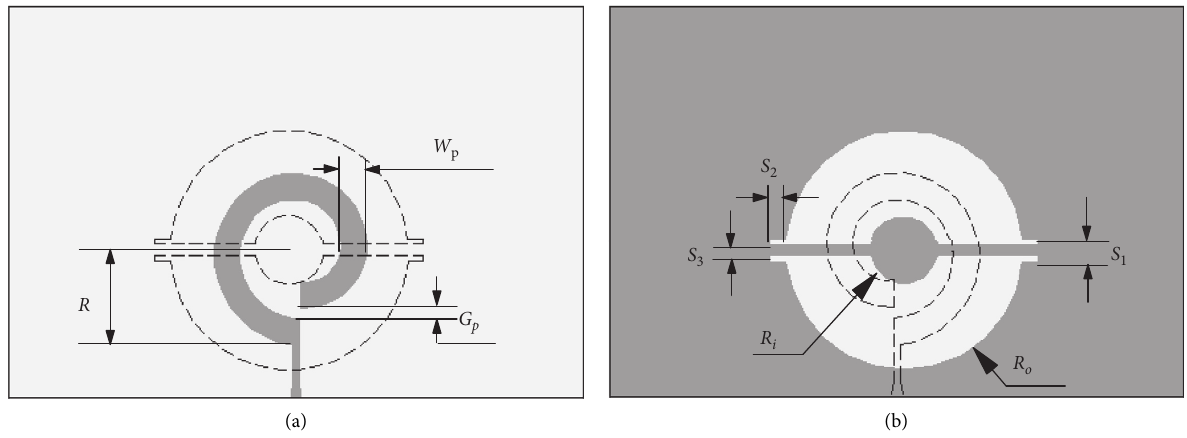
Figure 2: Detailed views of the proposed radiating element: (a) top view and (b) bottom